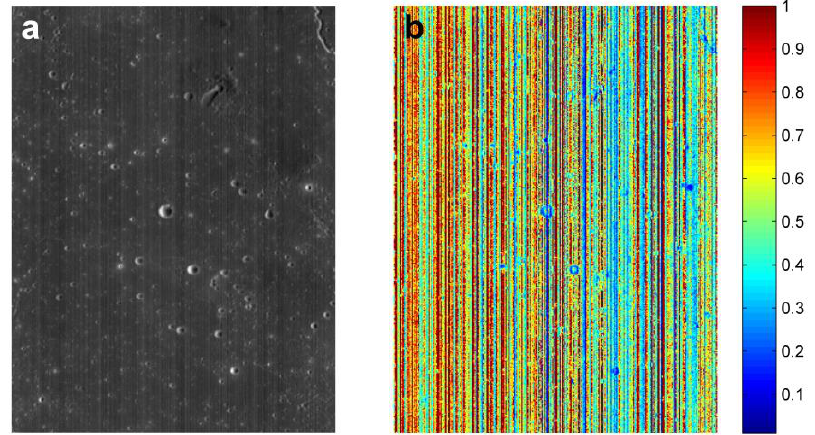
Figure 16. ( a ) M 3 750 nm reflectance image of the mare region to the north of Reiner Gamma; ( b ) npFe 0 abundance distribution.